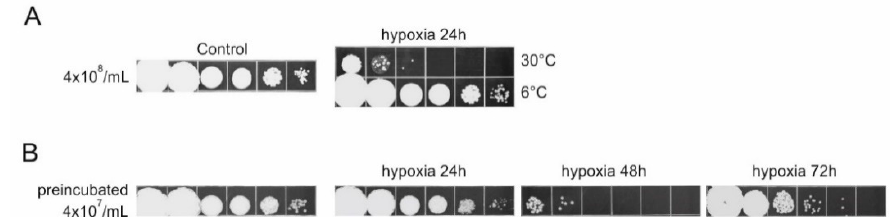
Figure 2 . Oxygen-consuming metabolism affects cell survival under limited oxygen. ( A ) One milli- liter of 4 × 10 8 dense cell suspensions were incubated in water in 1.5 mL tubes at 6 °C or 30 °C, for 24 h; 10-fold serial dilutions were spotted on the solid growth medium. ( B ) Stationary cell culture, washed and brought to a density of 4 × 10 7 /mL was incubated in water for 24 h, prior to concentrat- ing to a density of 4 × 10 8 /mL. One milliliter aliquots of high-density suspension were distributed in three 1.5 mL tubes and further incubated under limited aeration for 24 h, 48 h, or 72 h. At each time- point, suspension from a single tube was used for preparation of dilutions and were spotted on the solid medium. All experiments were performed at least three times and the representative results are shown.